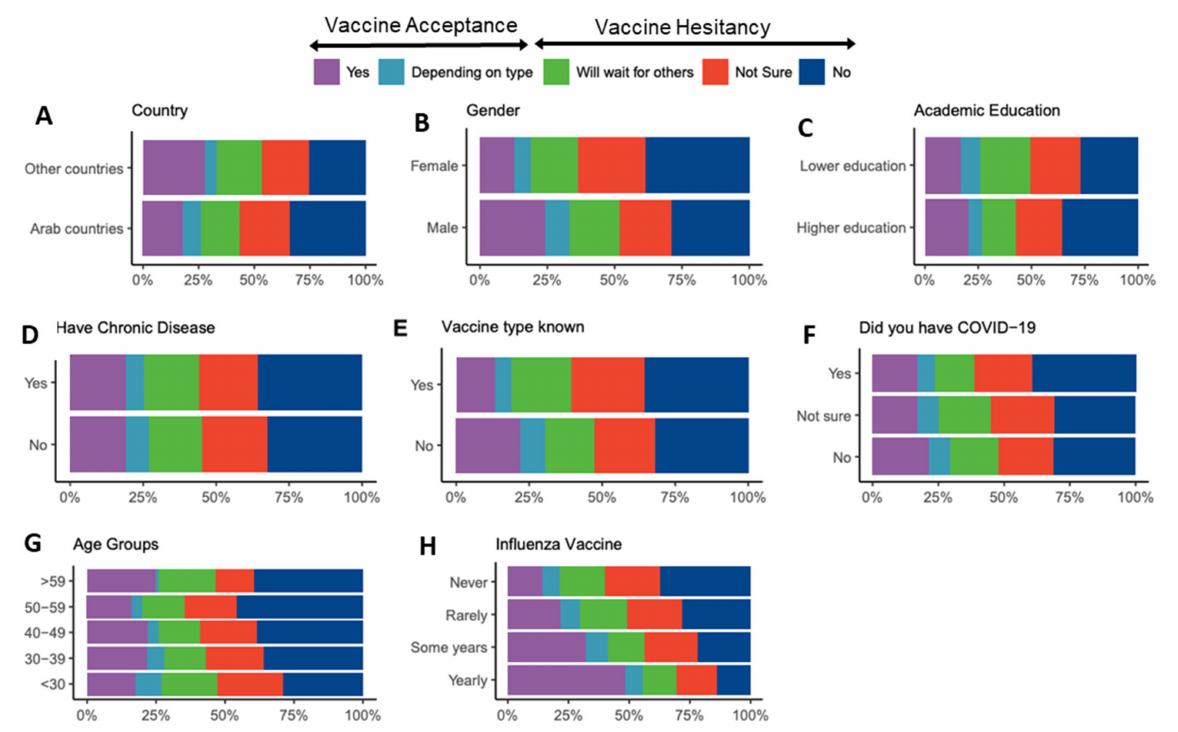
Figure 2. Differences in COVID-19 Vaccination attitudes among HCWs according to: ( A ) country of residence, ( B ) gender, ( C ) level of academic education, ( D ) having a chronic illness, ( E ) knowing the vaccine type available in participant’s country, ( F ) having a previous or current COVID-19 infection, ( G ) age, and ( H ) receiving annual influenza vaccine.